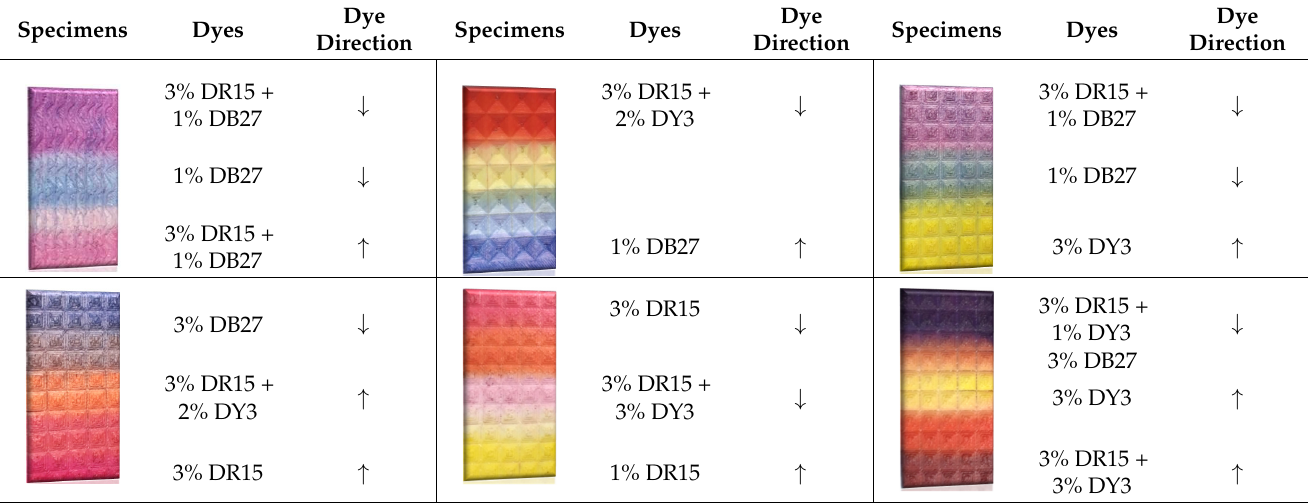
For blue specimen, the color characteristics show decreases in chroma (C *) as the color concentration increases, which is characteristic for the blue hue. The lightness value (L*) also decreases significantly with increasing dye concentration. A significant change in hue (h°) was obtained with increasing dye concentration. The hue changes from blue (h° = 276.19 for dye concentration 0.2%) to violet (h° = 314.17 for dye concentration 4%). The remission curves confirm the change in spectral characteristics of the color with a change in concentration. As the dye concentration increases, the pronounced reflectance peak in the blue spectrum decreases and the height approaches the maximum in the red spectrum. This confirms the change in spectral characteristics of color from blue to violet. The decrease in lightness with increasing dye concentration manifests itself in lower values of total reflectance. The K/S (color depth) curves confirm the above. The total value of K/S, i.e., the color depth, increases with increasing concentration. 3.2. Ombre Effect The 3D printed objects ABS, dyed with a combination of disperse dyes, and the color effect obtained are shown in Table 10. The dilutions of the baths in terms of con- centrations and gradients were adjusted based on the results shown in Section 3.1. In the test specimens shown in Table 10, a color effect of a gradual, fading color transition was obtained. From the point of view of artistic analysis, since the final application is the de- sign of footwear, it can be said that the effects show a high degree of harmonic balance and the color combinations are in a positive contrast relationship. Table 10. Specimens obtained with a mixture of dyes with an ombre effect (D c according owm). Specimens Dyes Dye Direction